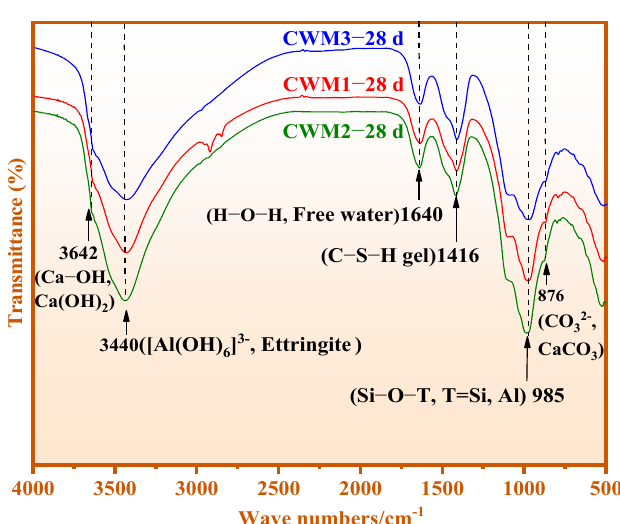
(Al-OH), Si-OH, and Si-O-T bonds in CWM2 are higher than those of other CWMs. This result indicates that more C-S-H gel, C/N-A-S-H gel, and ettringite are generated in CWM2- 28 d. The reason is that the formation of more hydration products in the CWM is promoted by the PS admixture compared with HBFS and GS. Thus, the polymerized structure of CWM2 is the highest than others.